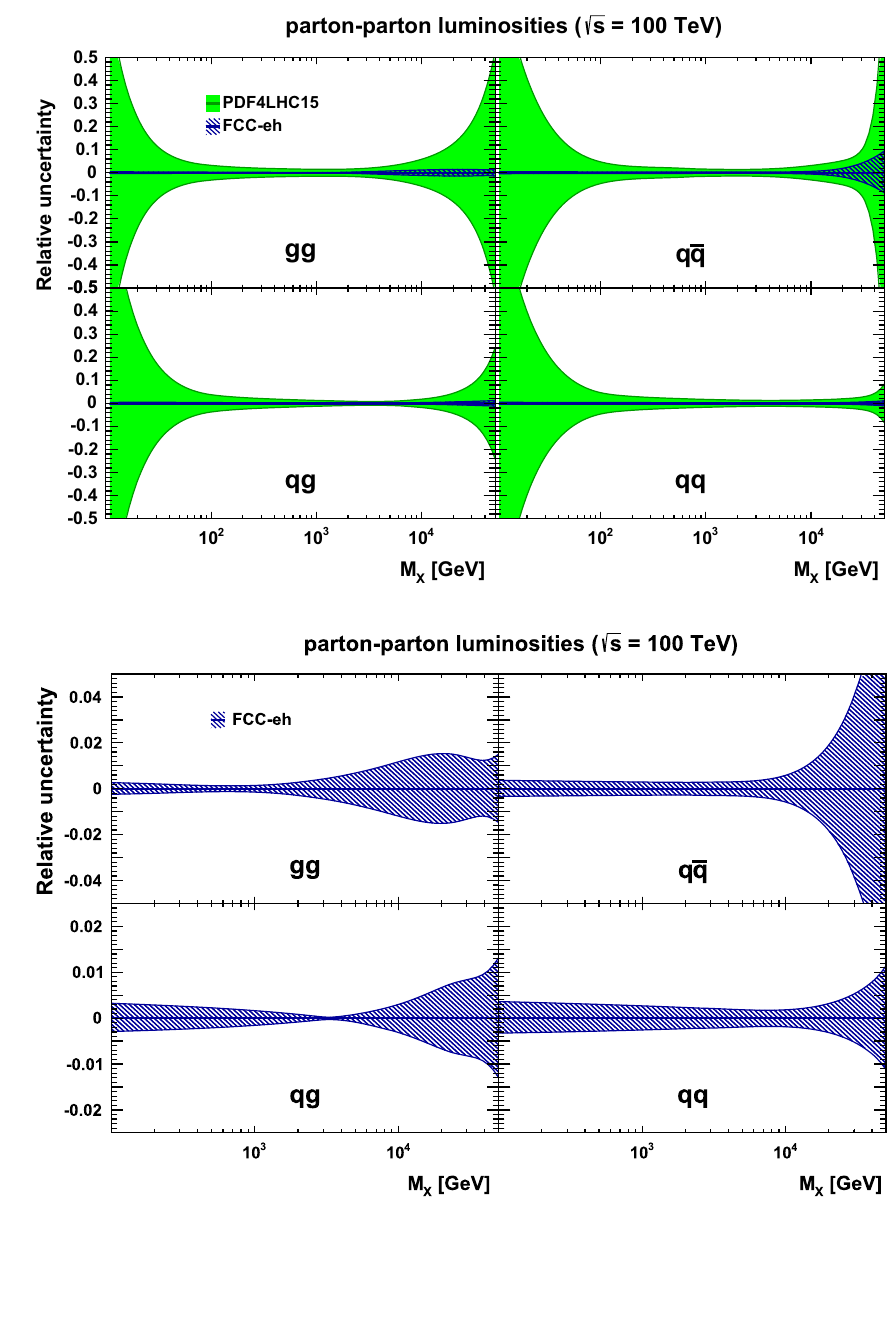
PDF4LHC15 FCC-eh